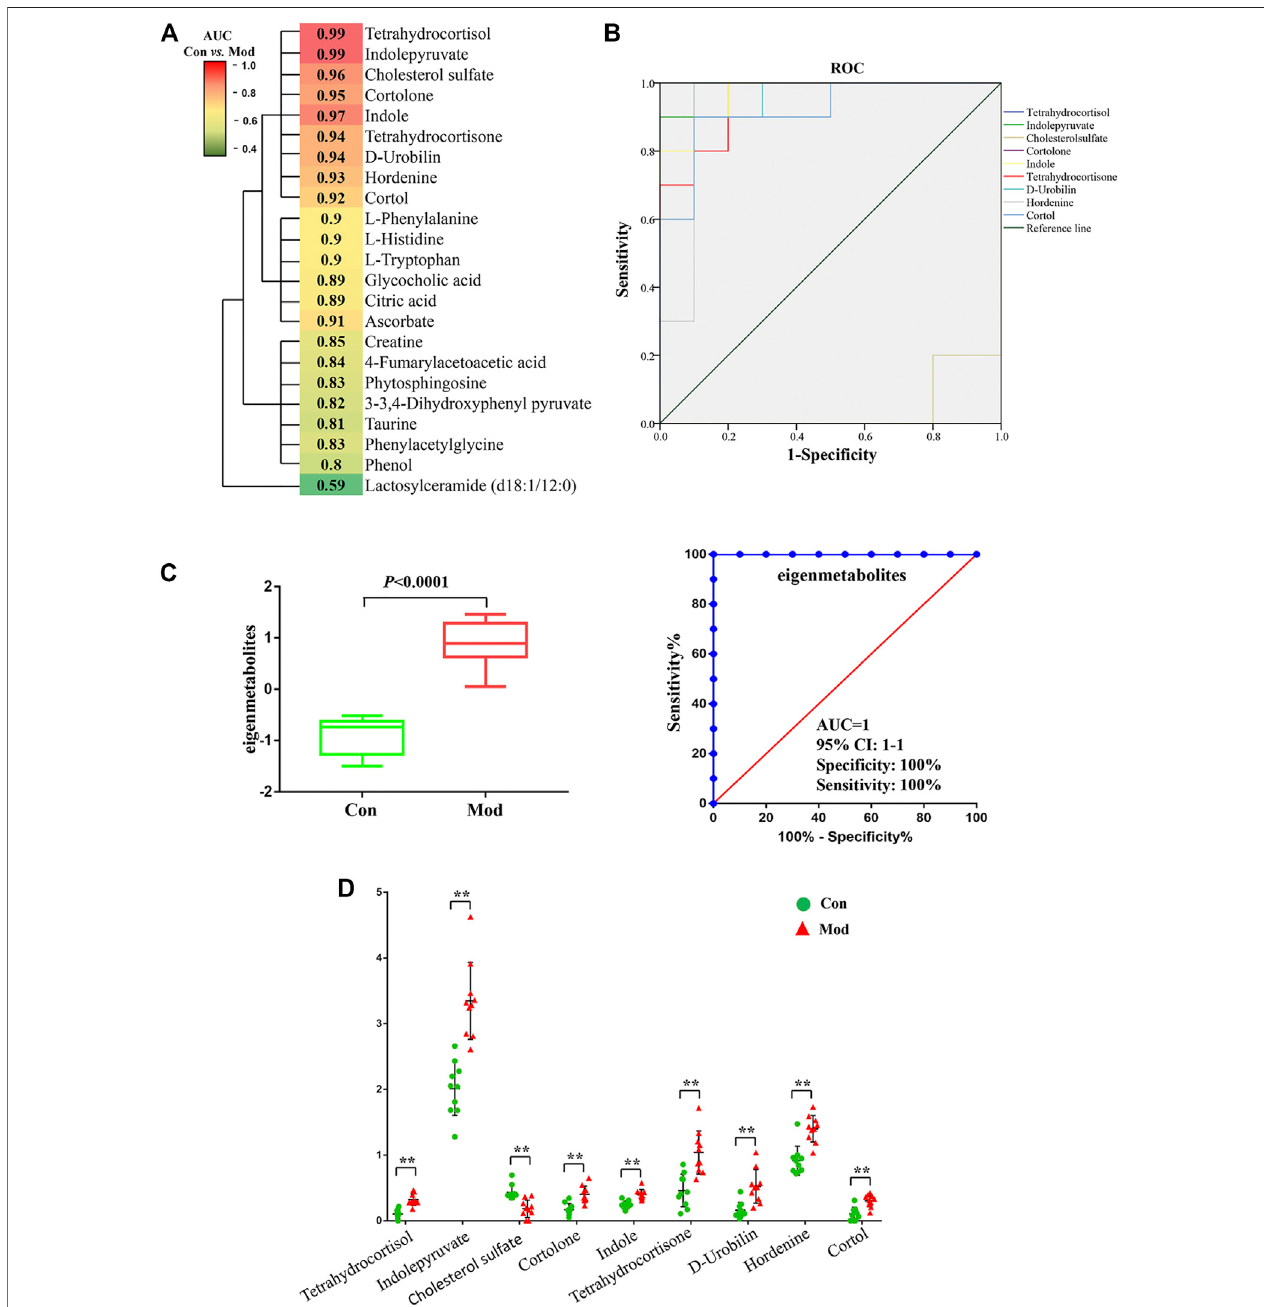
FIGURE 5 | Susceptibility-related metabolite biomarkers of Dicl-IDILI. (A) Cluster analysis of the area under the curve (AUC) and p -values of the receiver operating characteristic (ROC) curve ofeach ofthe23metabolites indiscriminating thesusceptibilitymodel(Mod) groupfrom thecontrol(Con) group.The colorindicates theAUC value. (B) ROC curves of nine metabolites in discriminating the Mod group from the Con group. (C) Identi fi cation of the susceptible-related metabolic fi ngerprint (eigenmetabolite). (D) Differential expressions of nine metabolites in the Mod group and the Con group ( p p < 0.05, pp p < 0.01 vs. Con).